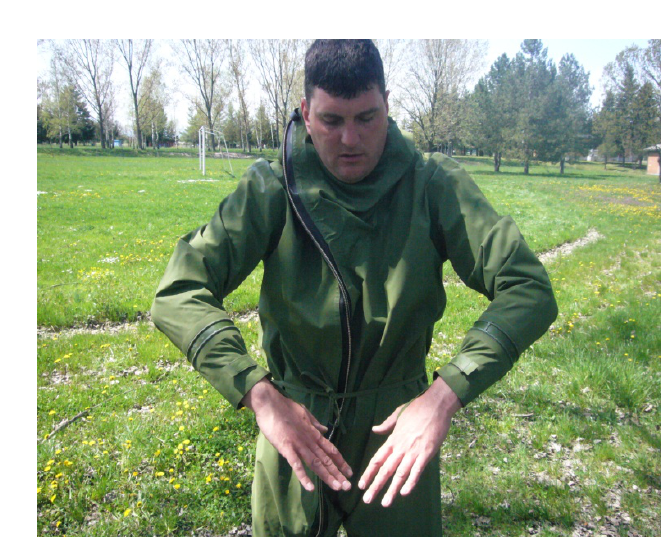
Figure 6 – Reduced arm mobility at the elbow (Tehni č ki opitni centar, 2015) Рис . 6 – Ограниченная подвижность рук в области локтевого сустава (Tehni č ki opitni centar, 2015)